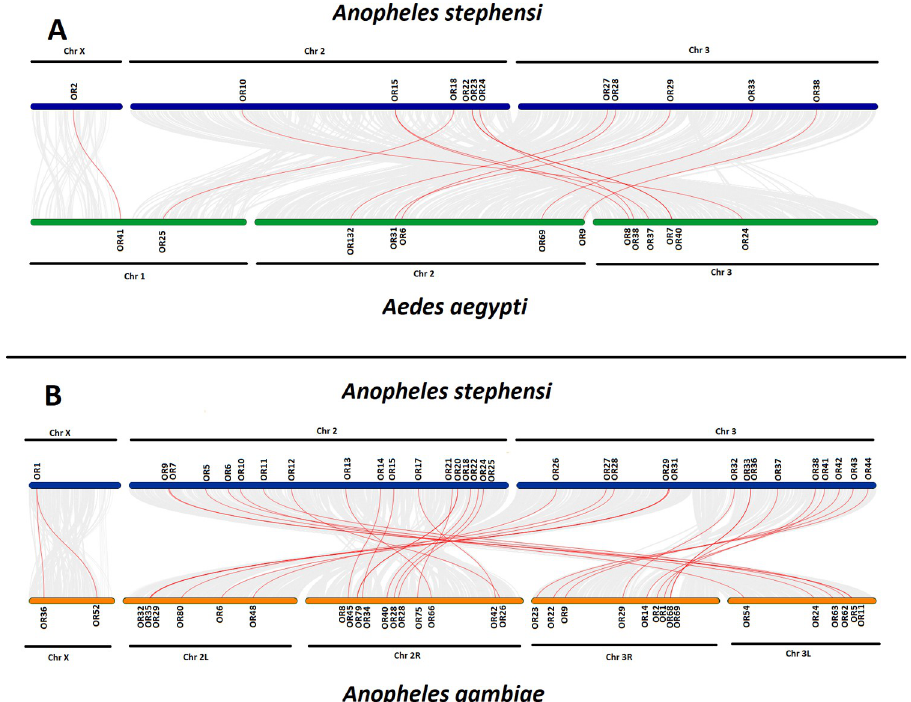
Fig 8. Synteny analysis of ORs. Synteny analysis were carried out to find the collinear blocks between the ORs of An . stephensi and ORs of (A) Ae . aegypti and (B) Ae . gambiae . Chromosomes and chromosomal position of the ORs have been shown along with the lines showing synteny between the ORs. Red lines represent the syntenic relationship between the ORs of An . stephensi with Ae . aegypti (A) and An . gambiae